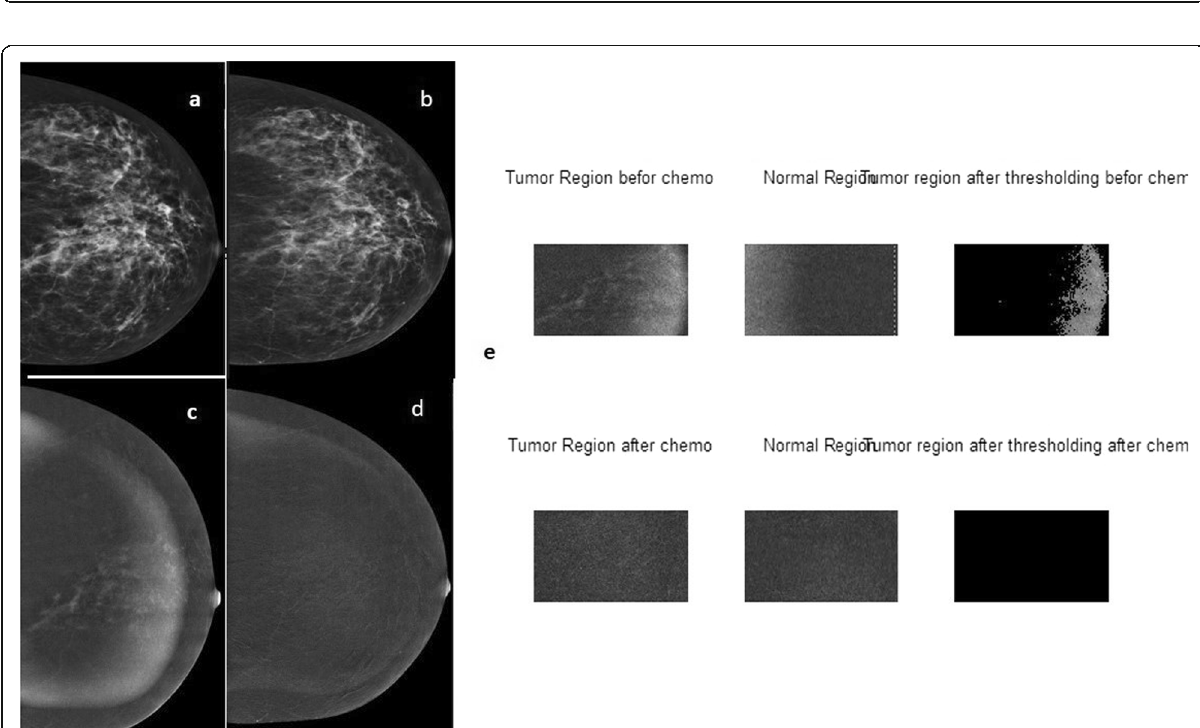
Fig. 5 Comparison between the quantitative mathematical objective evaluation, RECIST 1.1 method, and the combined method in correlation to the corresponding histopathology Miller – Payne